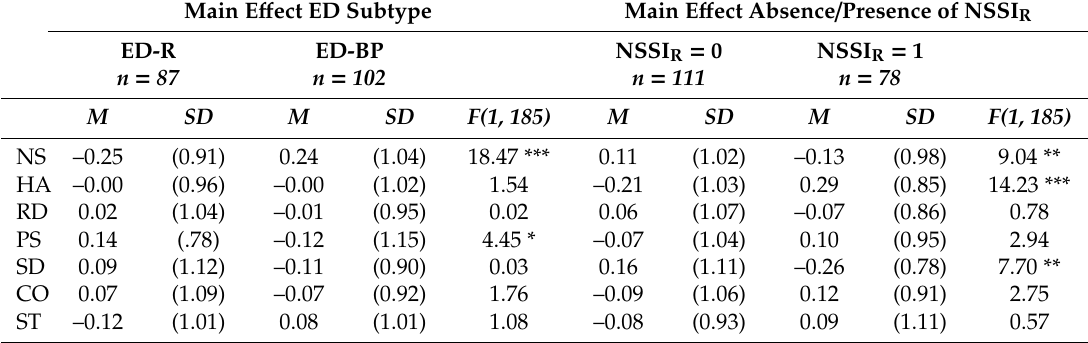
Means and standard deviations of the z -scores of the brief Dutch version of Cloninger’s Temperament and Character Inventory for ED-R / BP patients with(out) recent NSSI (last week / last